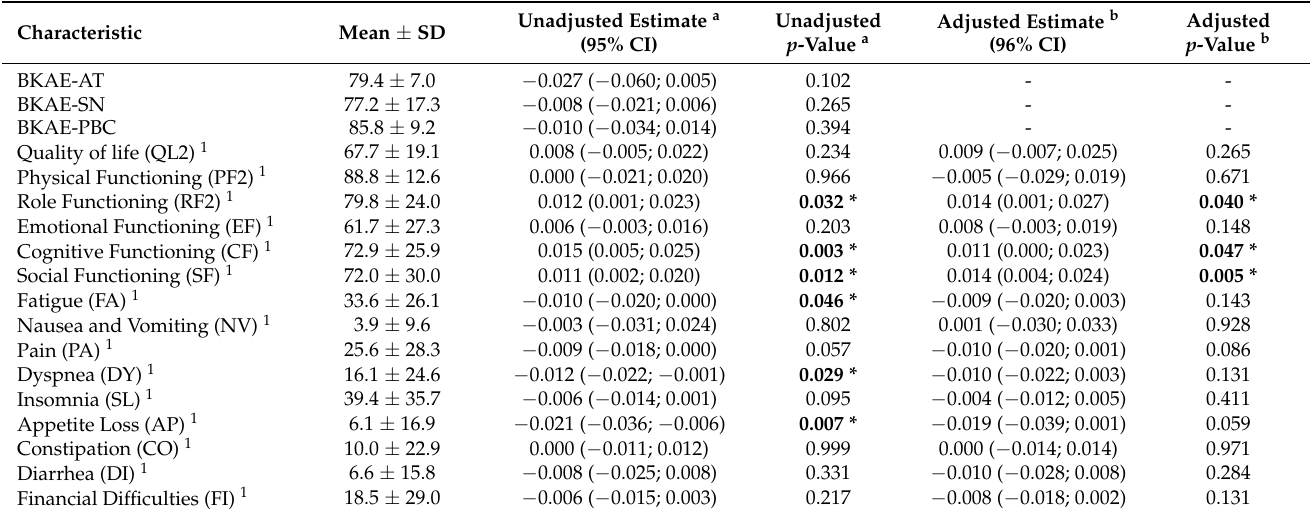
Table A4. Associations between DII and EORTC-QC30 scores adjusted for attitudes towards, social norms about, and perceived behavioural control over healthy